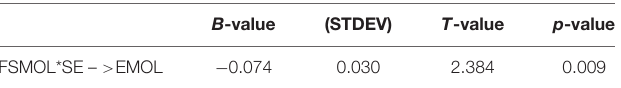
TABLE 5 | Mediator hypothesis testing.